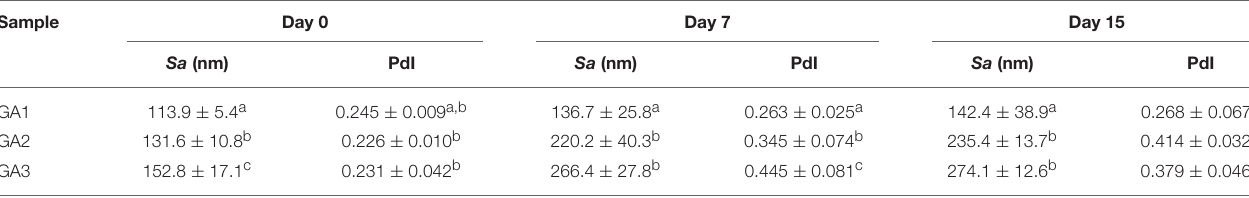
TABLE 3 | Size average ( Sa ) and polydispersity (PdI) of micelles produced with galactomannan acetate with increasing acetylation degrees (GA1, GA2, and GA3) during storage.